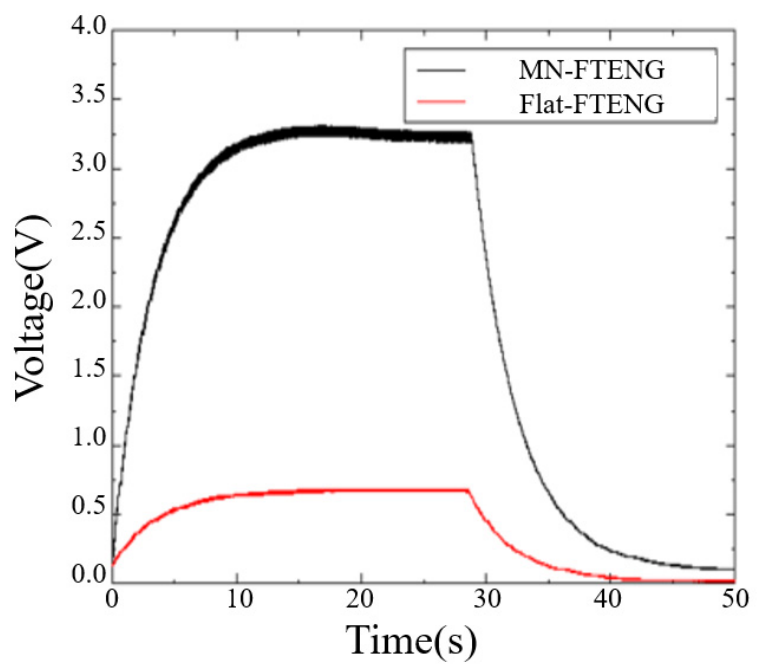
Figure 7. Charge–discharge curves of MN-FTENG and FTENG with 3.3 μ F capacitors, it shows that the unstructured FTENG can charge 3.3 μ F to 0.7 V in 20 s, while the 374 μ m MN-FTENG can charge 3.3 μ F to 3.3 V in 15 s. Additionally, the unstructured FTENG takes 14 s from saturation to full discharge, and the MN-FTENG takes more than 21 s from saturation to full discharge.